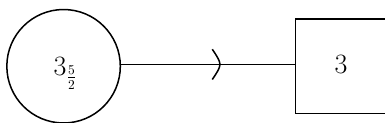
(2) x which is dual to T x with a contact term for the SU(3) global 3 Figure 2 . The theory T